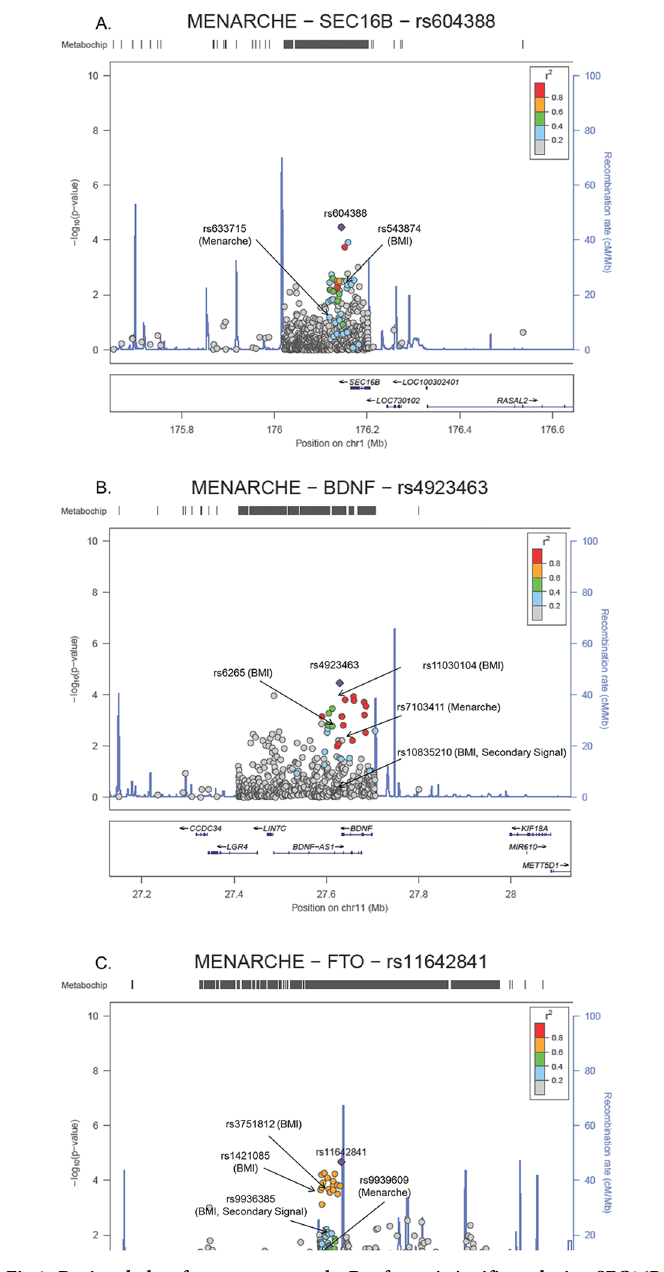
Fig 1. Regional plots for age at menarche Bonferroni-significant loci at SEC16B (Panel A), BDNF (Panel B) and FTO (Panel C), showing previously published body mass index (BMI) primary and secondary SNP associations, using a modified random-effects trans-ethnic meta-analysis of more than 31,000 women.